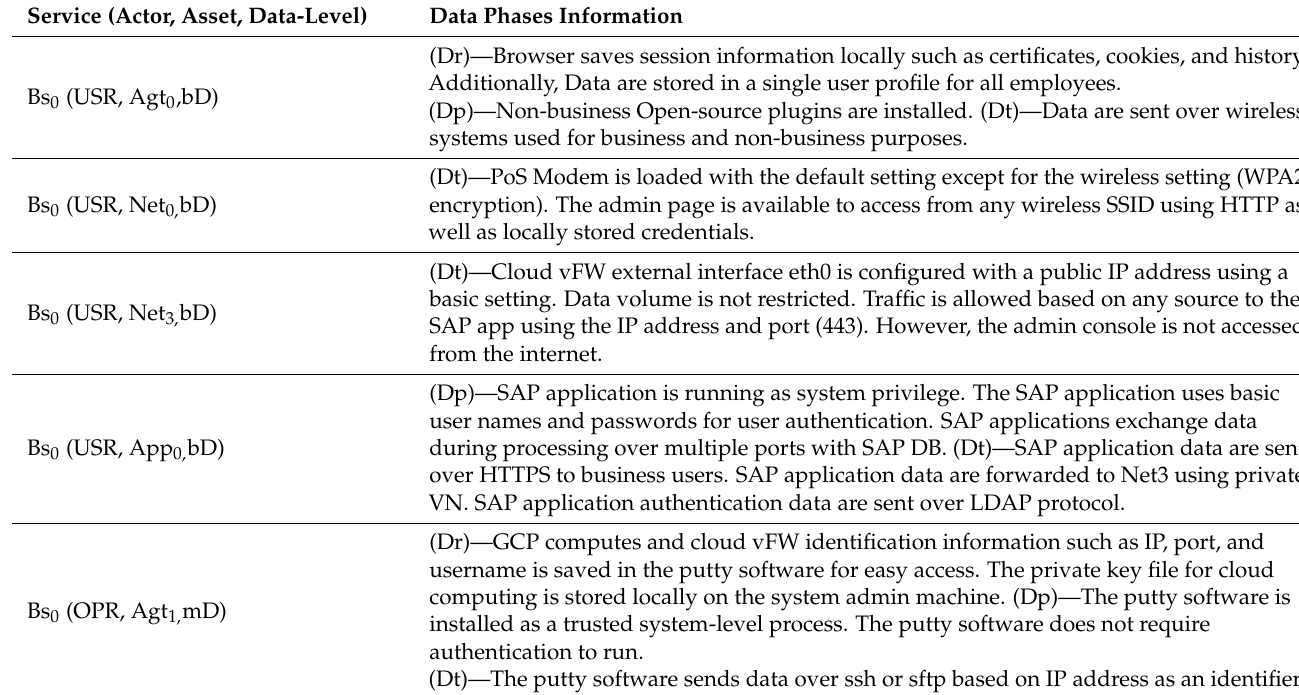
Table 6. Data level and phase